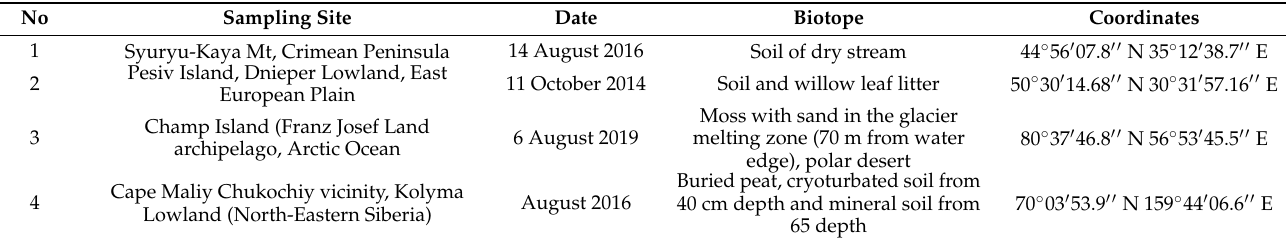
Table 1. Description of sampling